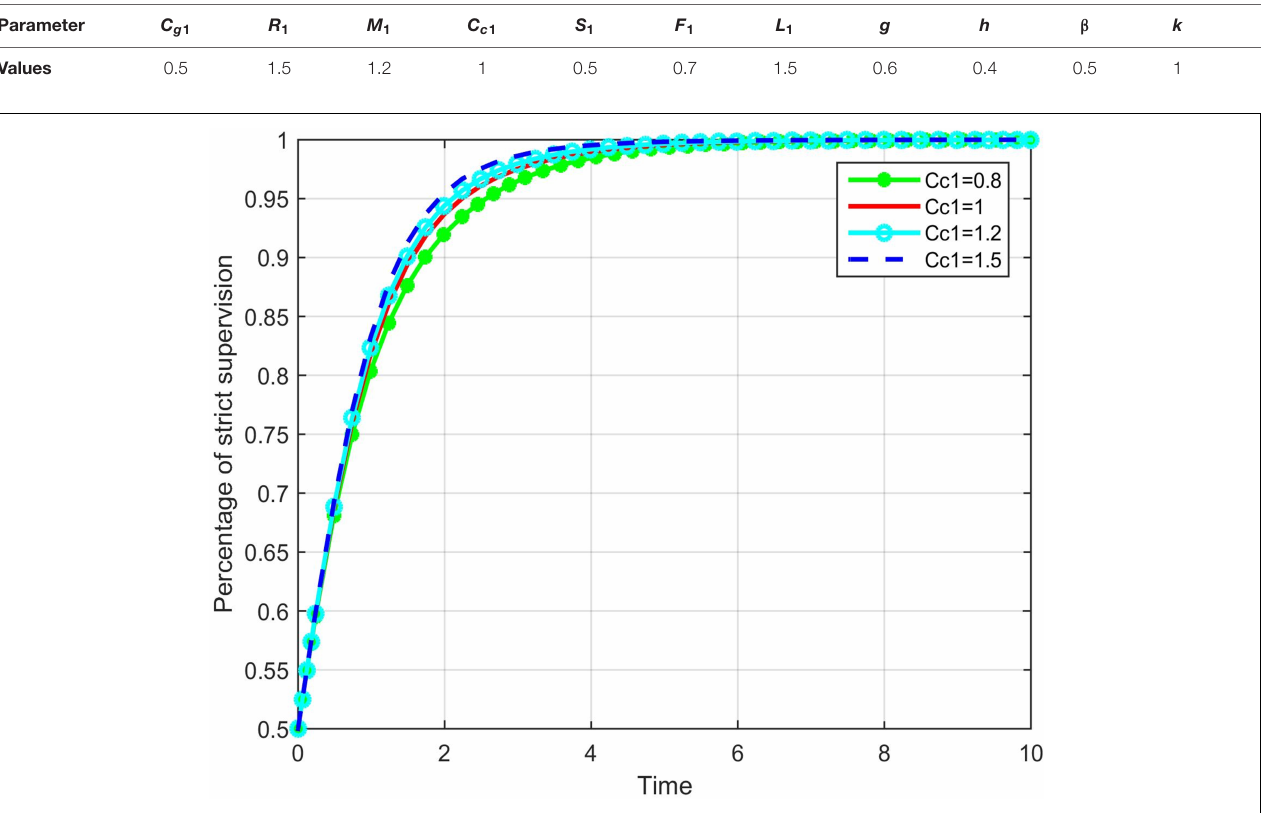
TABLE 5 | The parameter values.